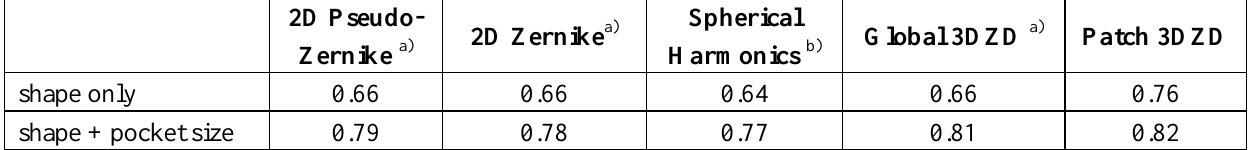
Table 2. Average area under the ROC curves of different pocket descriptors.